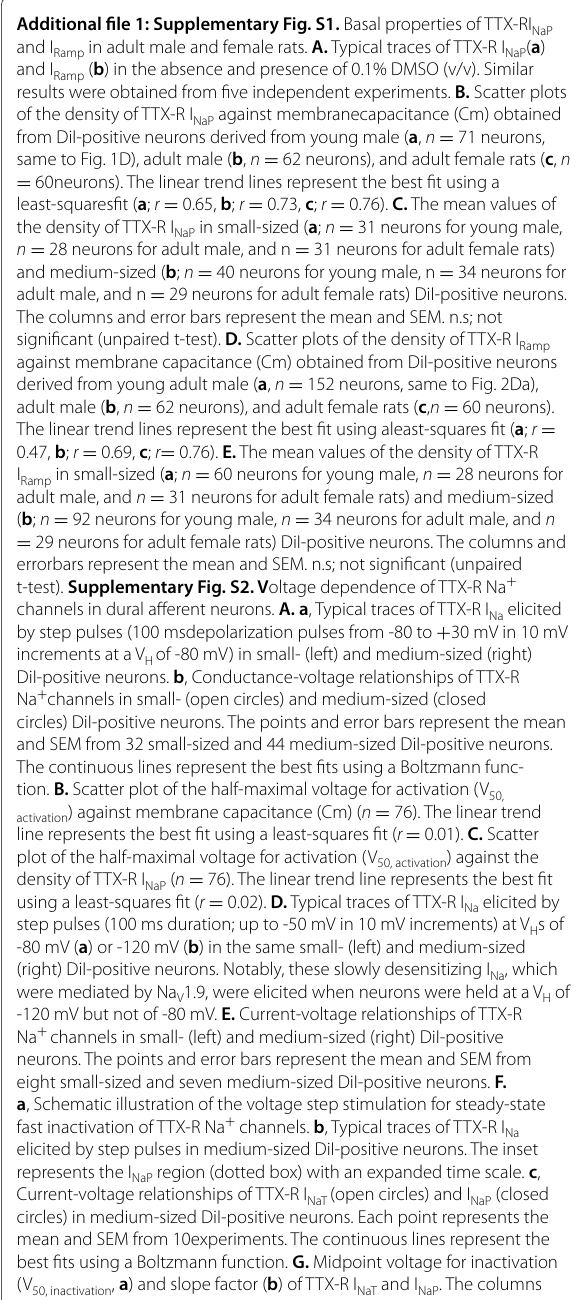
tary Fig. S4. Kinetic parameters for the recovery from inactivation of TTX‑R Na + channels in dural afferent neurons. A. Schematic illustration of the two‑pulse protocol used for the recovery from inactivation of TTX‑R Na + channels. TTX‑R I Na were induced by the conditioning prepulse (P 1 : ‑10 mV; 500 ms duration), which was followed by the test pulse (P 2 : ‑10 mV; 50msduration). The second TTX‑R I Na was recovered with various interpulse intervals of 1–5,000 ms at a V H of ‑80 mV. B. The mean values of